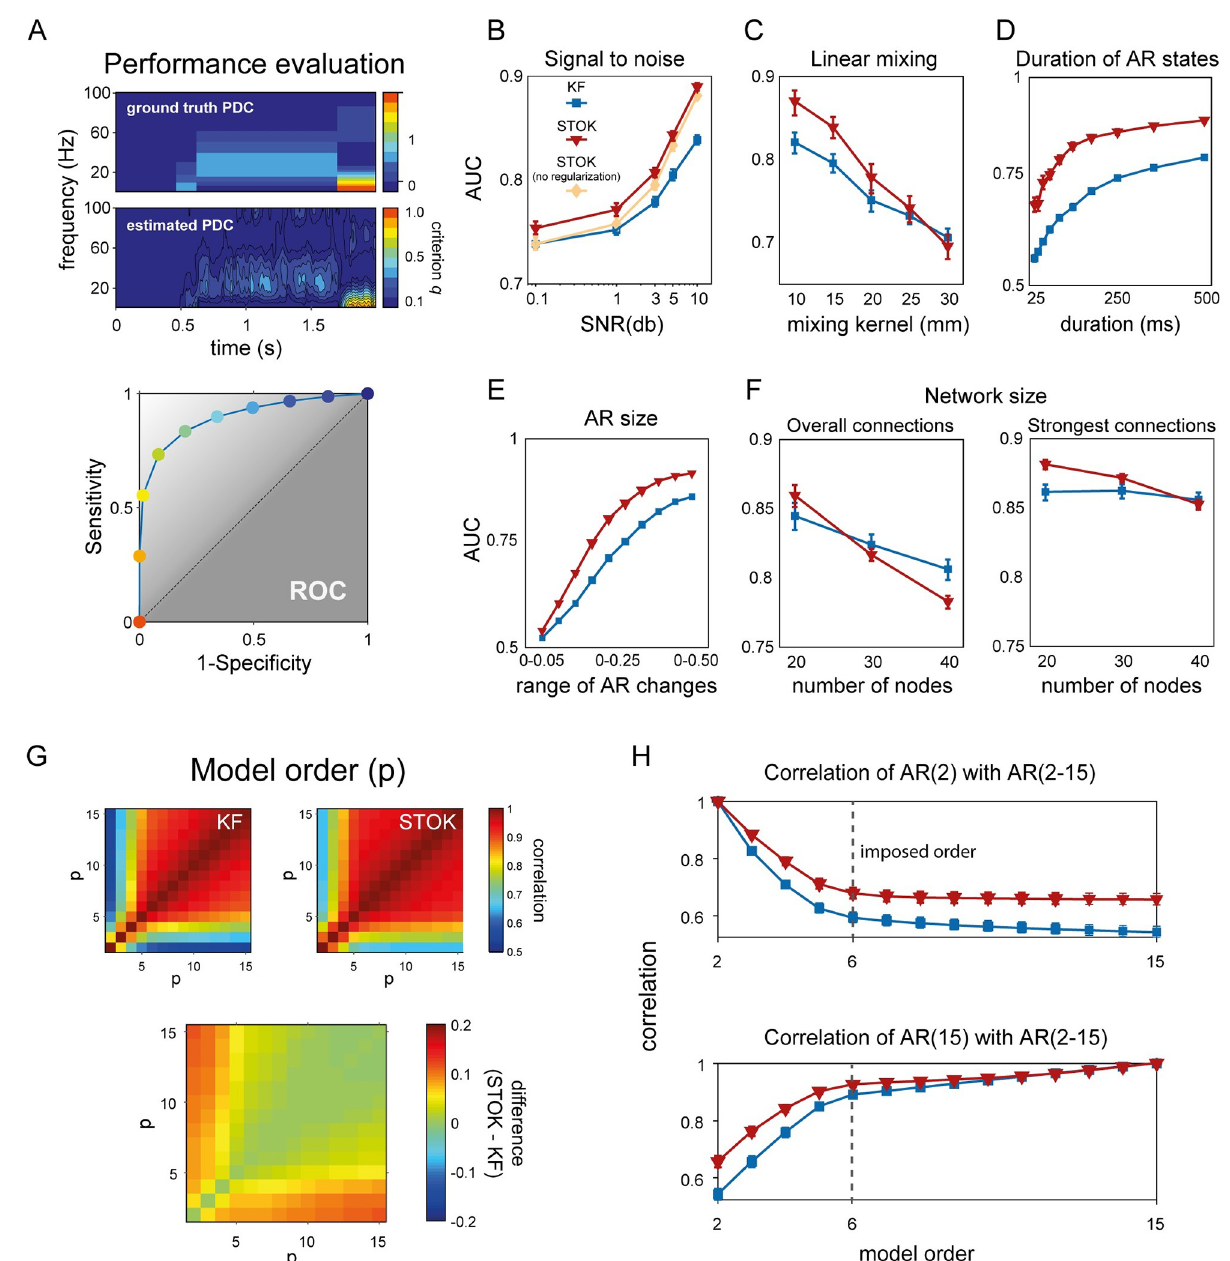
Fig 2. Comparison of the KF and STOK filters under the realistic simulation framework. (A) Method for evaluating the performance of KF and STOK against simulated data (ground truth). Ground truth PDC was binarized setting to 1 all connections larger than 0. Estimated Partial Directed Coherence (PDC) [41] was binarized using different criteria, based on the quantile discretization of the estimates ( criterion q ; top panel). Signal detection indexes were calculated for each criterion and the area under the curve (AUC) was used as performance measure. The color code of the dots in the ROC plot (bottom panel) reflects the different criteria and correspond to the colorbar for estimated PDC strength (top panel). (B) Comparison of KF, STOK without regularization and STOK as a function of different SNR, showing the overall larger AUC using STOK. Error bars reflect 95% confidence intervals. (C) AUC curves for KF and STOK as a function of linear mixing. (D-E) Performance of the two filters as a function of the duration (D) and size (E) of AR coefficients. (F) Performance of the two filters with increasing sample size: regularization favors strongest connections and sparse networks as the network size increases (right panel), reducing overall weakest connections (left panel). (G) Correlation matrices at varying model orders for KF and STOK (top two panels) and their difference (bottom panel, STOK minus KF). (H) Correlations extracted at specific orders ( p 2 [2,15], with ground-truth model order = 6) showing the higher consistency of models estimated as p changes with STOK compared with KF.